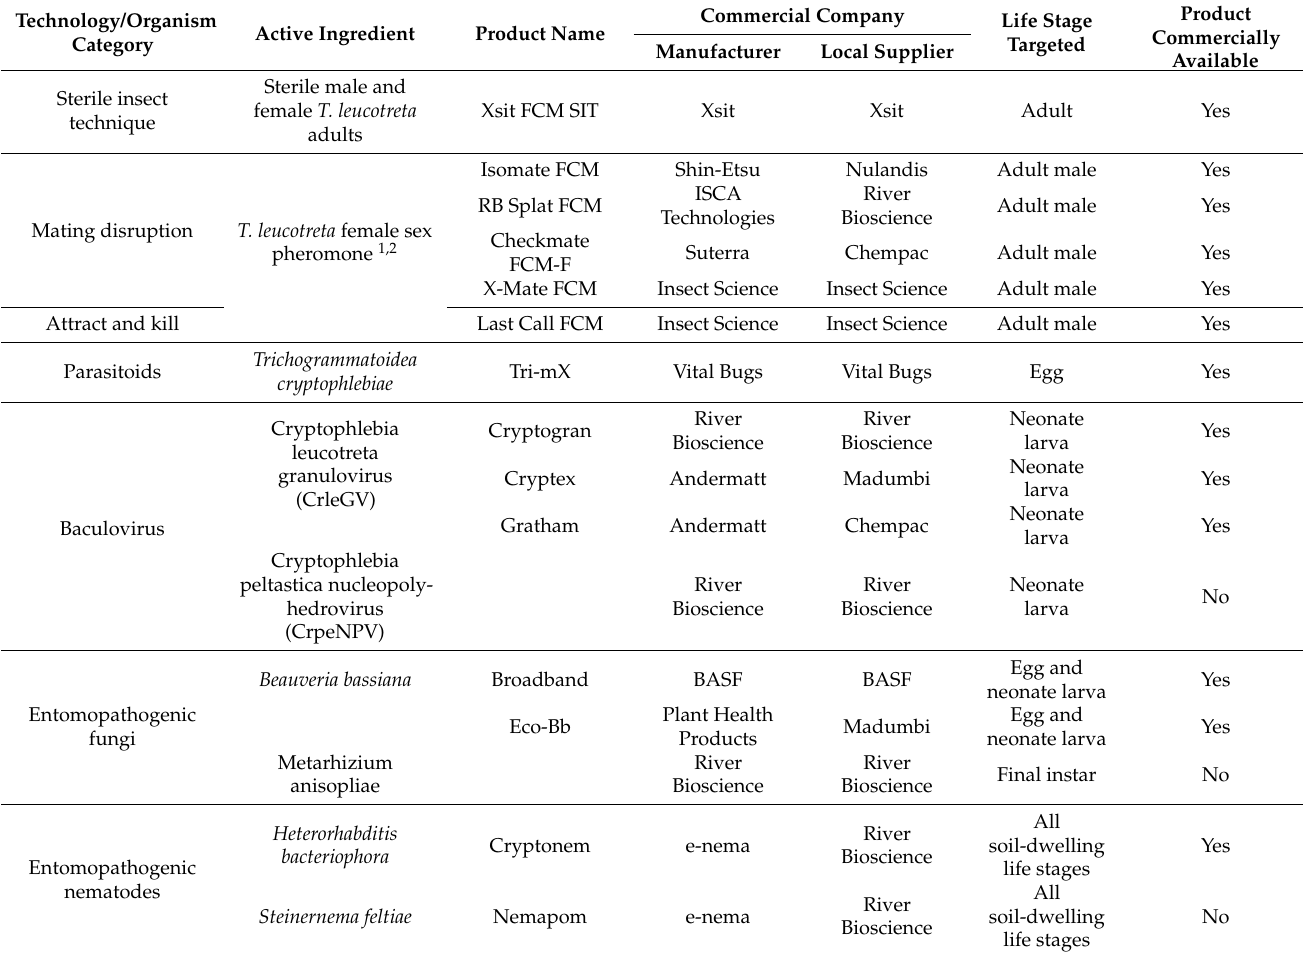
Table 1. Biopesticides developed or under development for control of Thaumatotibia leucotreta in citrus in South Africa. Technology/Organism